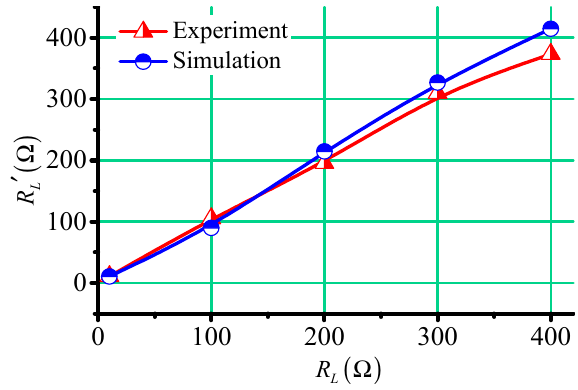
Figure 11. The resistances in the simulations and experiments.